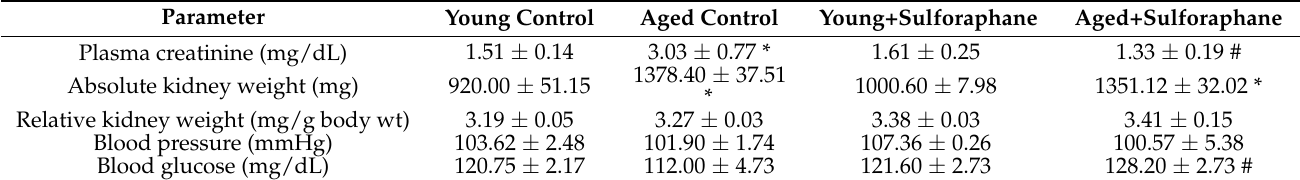
Table 1. Effect on sulforaphane on biochemical parameters, blood pressure and kidney weight. Parameter Young